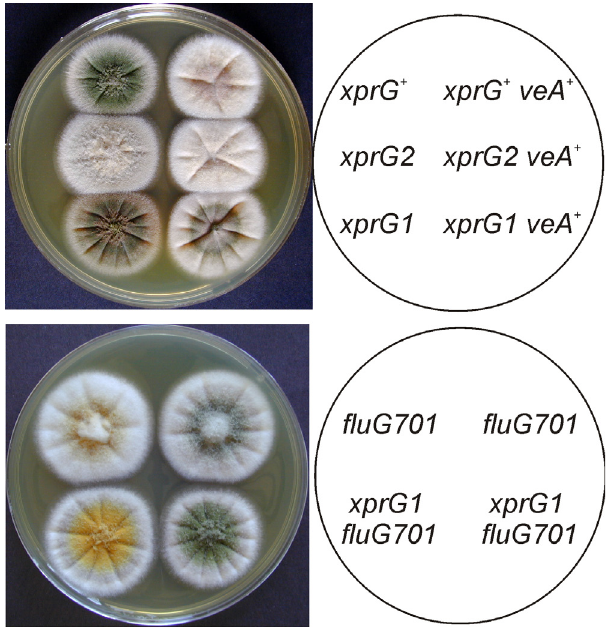
Figure 5. Interactions between the xprG , veA and fluG genes. A . Conidiation is suppressed by VeA in the dark but XprG1 partially restores conidiation in a veA + strain. The plate was photographed after 3 days of growth on complete medium at 37°C. Light was excluded by wrapping the plate in aluminum foil. The full genotypes of the xprG + (MH2), xprG2 (MK198), xprG1 (MK85), xprG + veA + (WIM-126), xprG2 veA + (MK565), and xprG1 veA + (MK563) strains are given in Table 1. B . The fluG gene is involved in producing an extracellular signal for the induction of conidiophore development 67 . The fluG701 mutation is partially suppressed by the xprG1 gain-of- function mutation. The full genotypes of the strains (top left MK593, top right MK592, bottom left MK595, bottom right MK594) are given in Table 1.